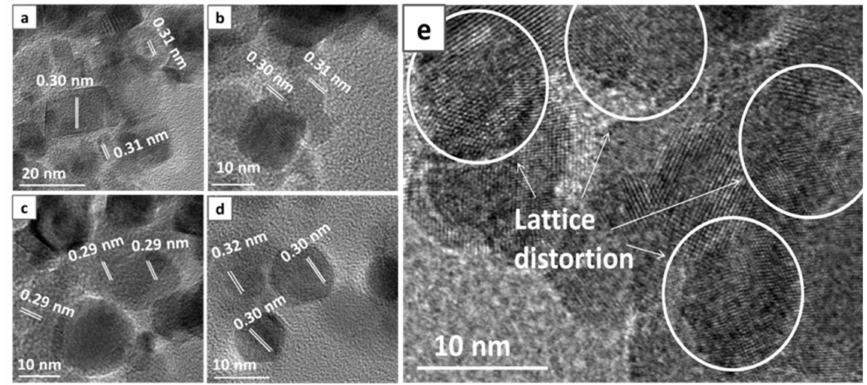
Figure 2. High resolution transmission electron microscopy (HRTEM) images of the representative samples: ( a ) 1% CuCe; ( b ) 9% CuCe; ( c ) 14% CuCe; ( d ) 17% CuCe; ( e ) high magnification of the 14% CuCe sample.